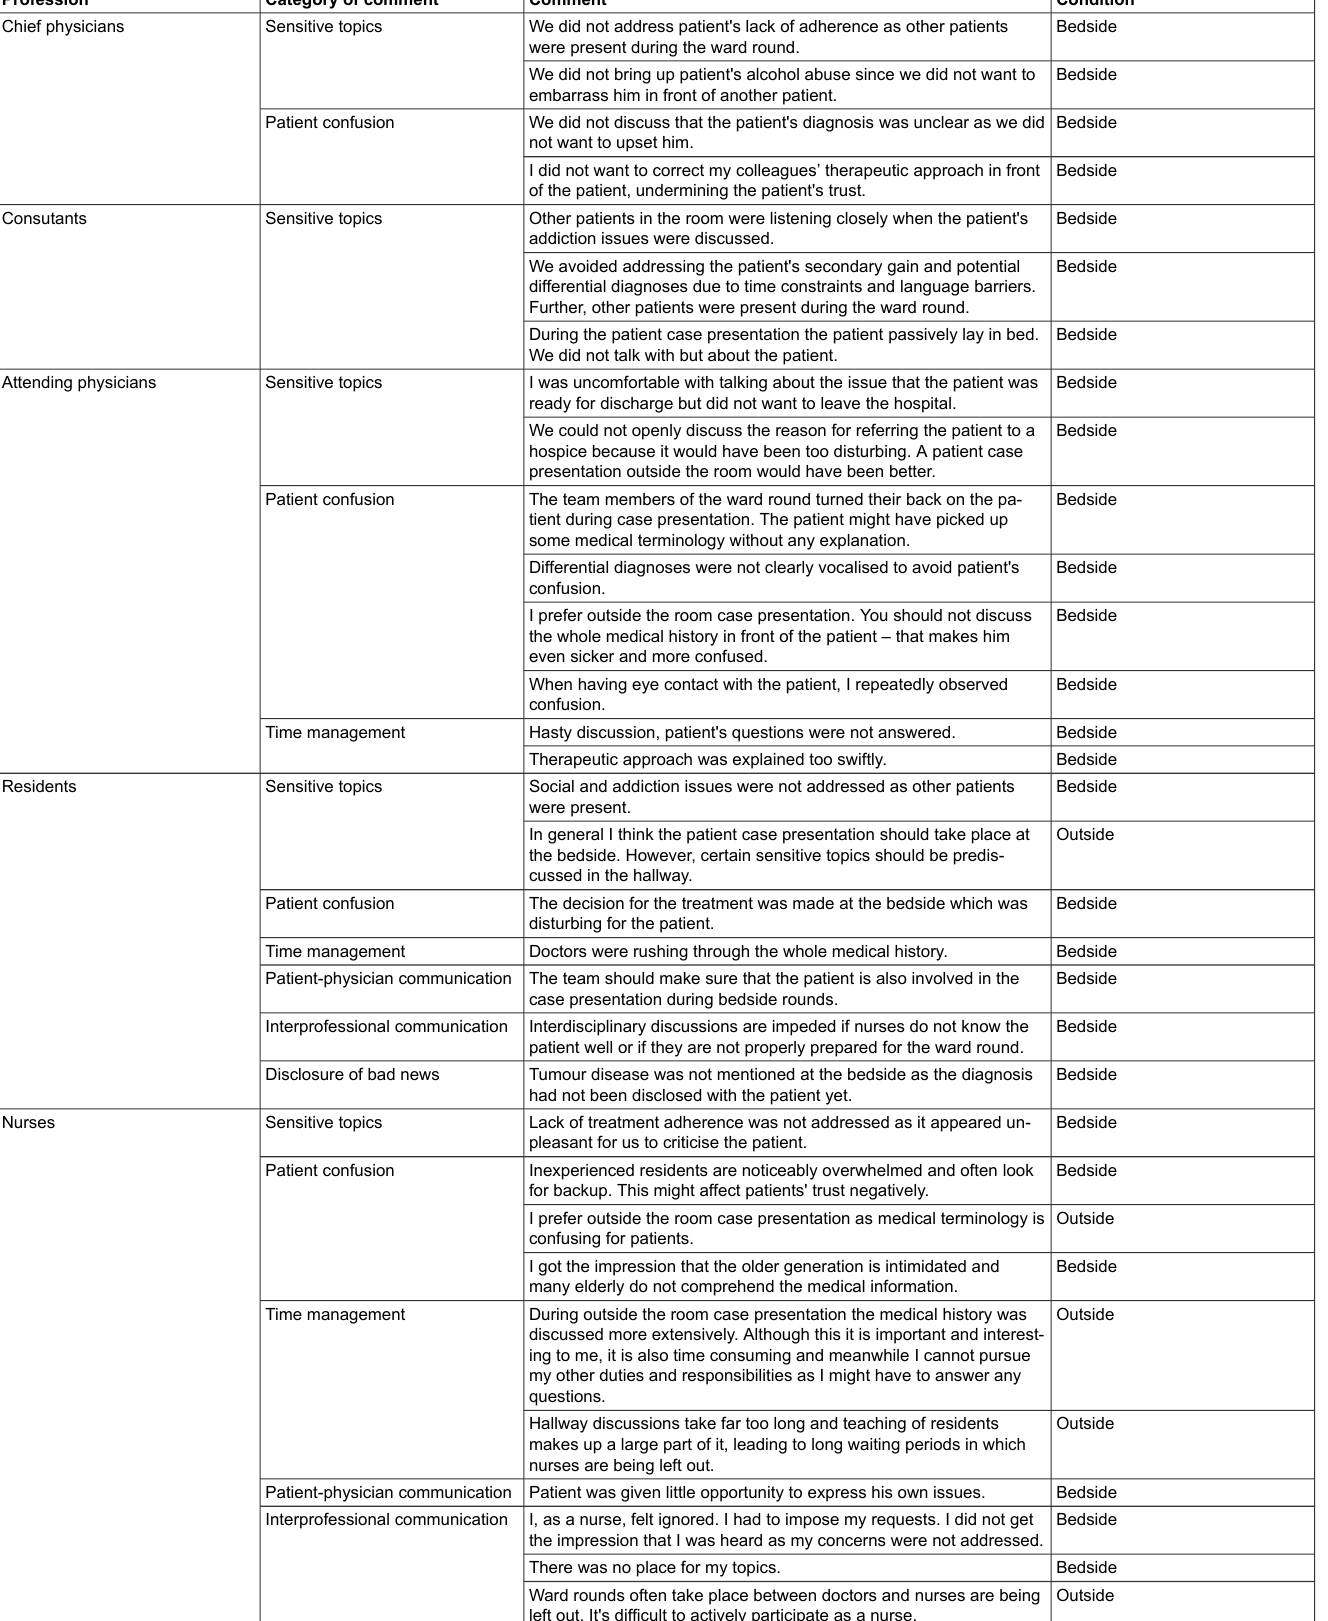
Table 3: Examples of healthcare workers’ comments on ward rounds.